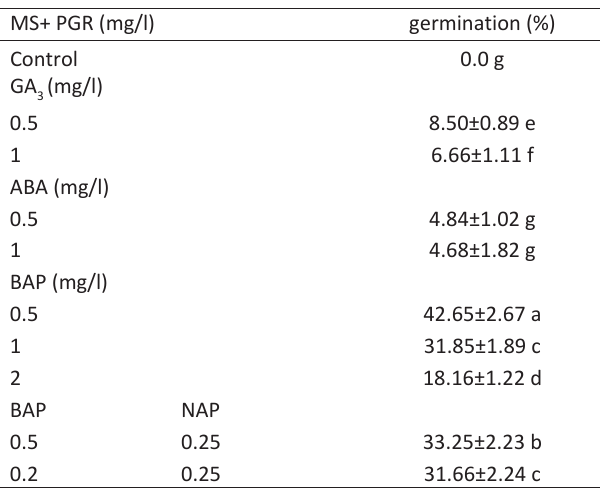
Table 4 - Somatic embryo germination in various PGRs added medium in Gladiolus. Data were scored after 6 weeks of culture